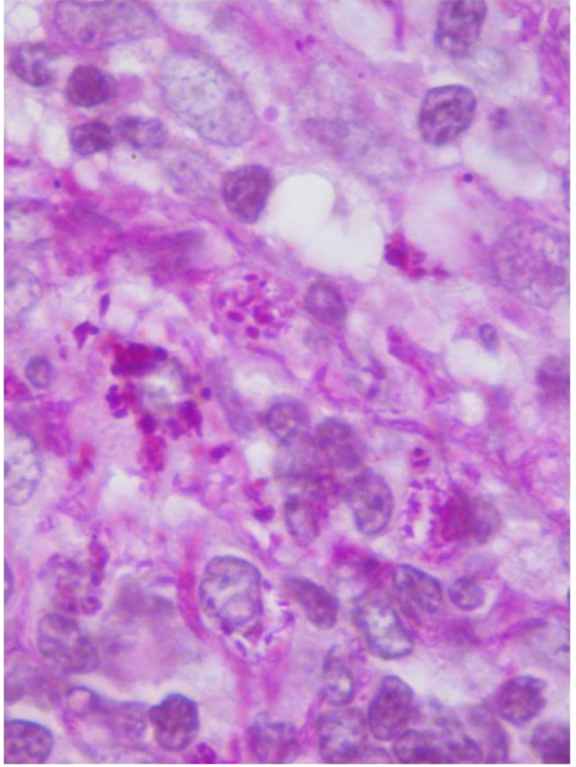
Figure 2: Ganglionic biopsy,